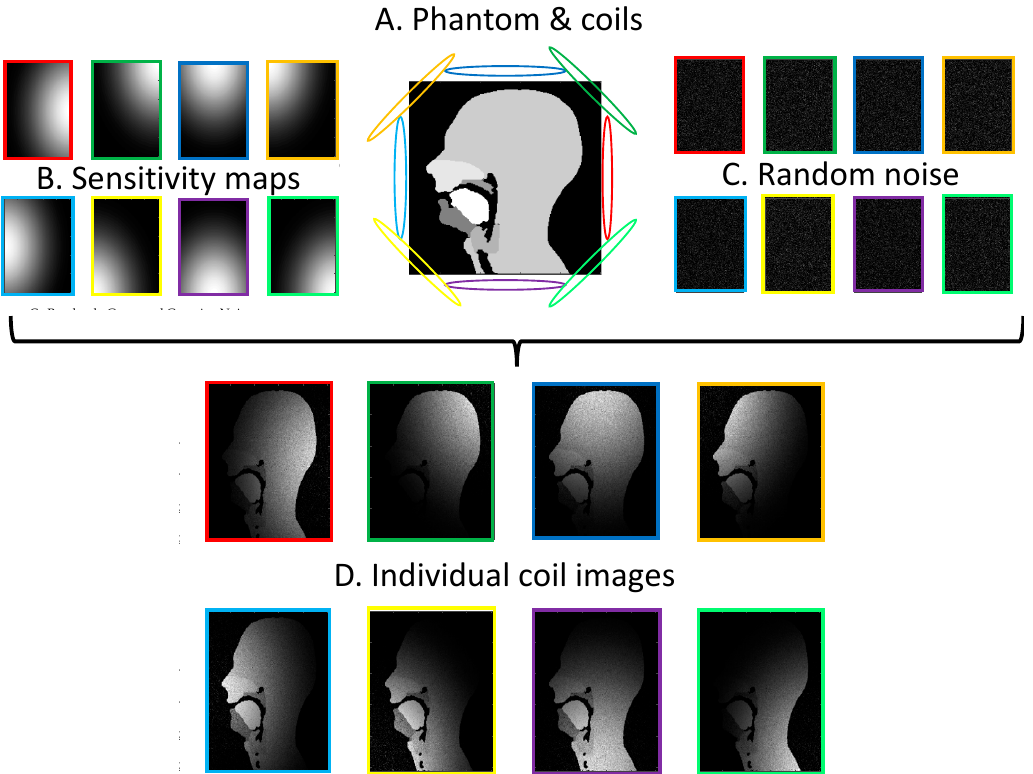
Figure 5. Creation of individual coil images for an 8-element array coil. The Hadamard product of the phantom images ( A ) with the coil sensitivity maps ( B ) and randomly generated Gaussian noise ( C ) results in simulated individual coil images ( D ).